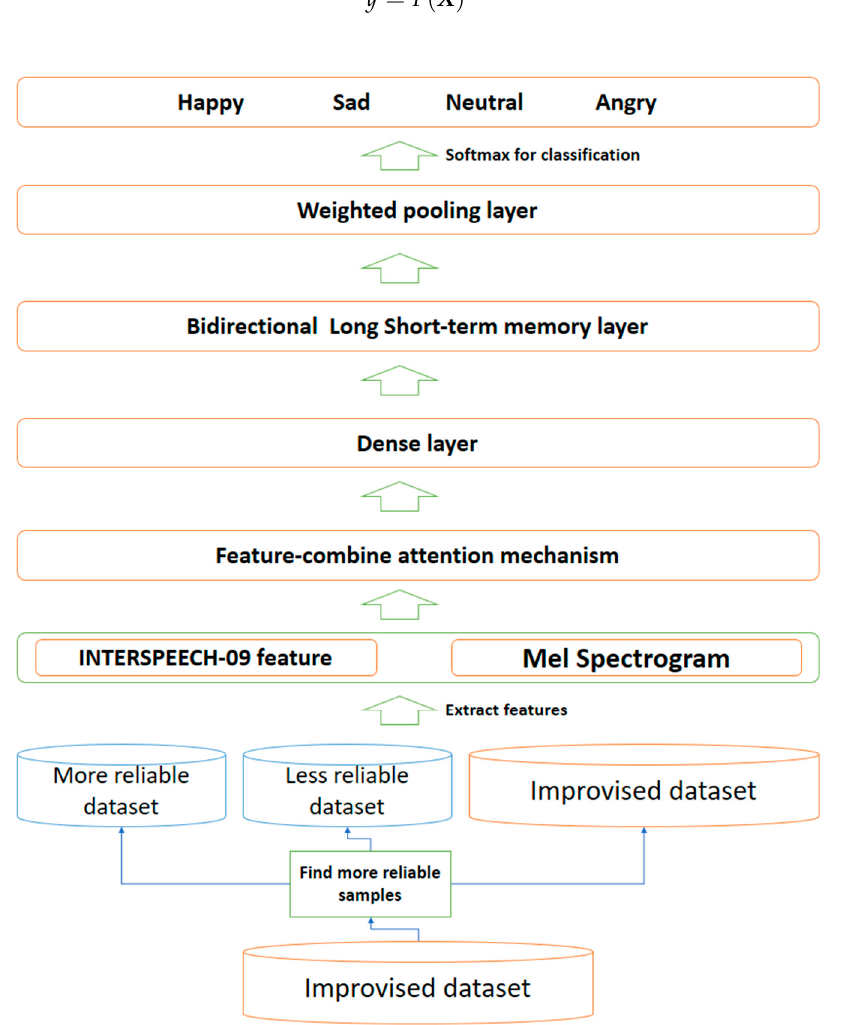
Figure 1. Architecture of our proposed research.